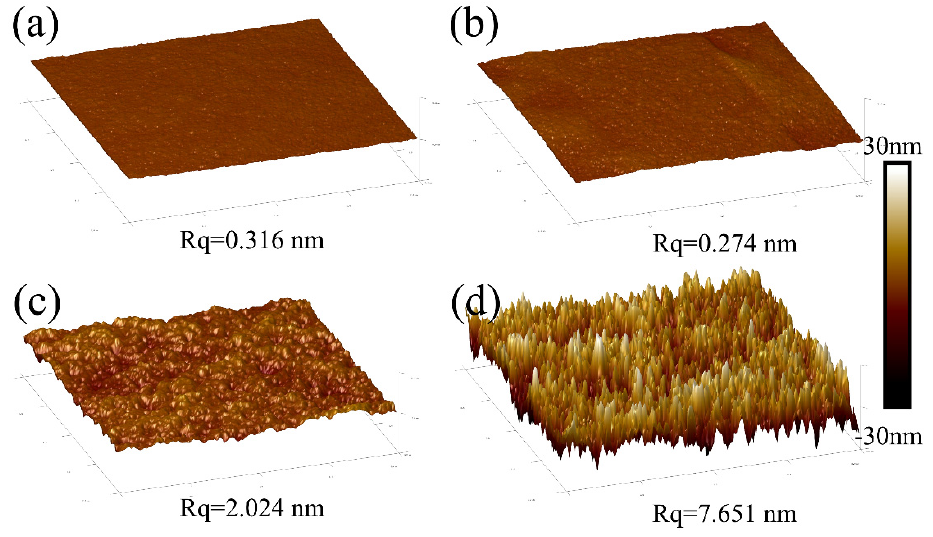
Figure 5. The 3D surface morphology of the coatings. ( a ) DETA-OSER. ( b ) MXDA-OSER. ( c ) NH 3 -OSER. ( d ) TM.